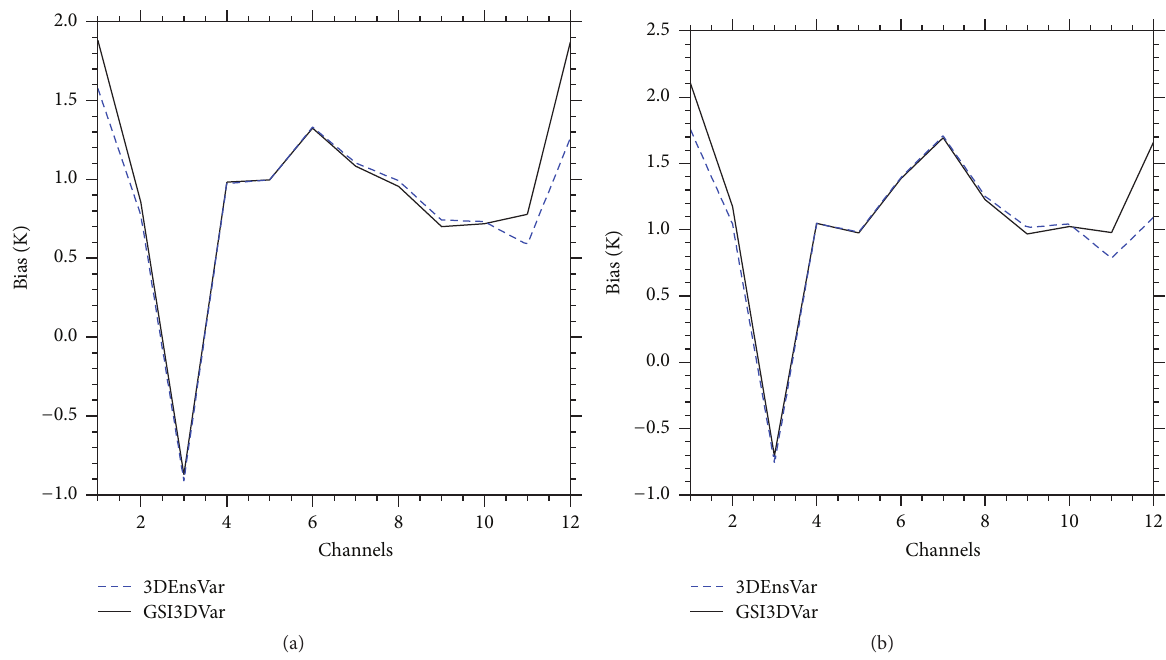
Figure 11: Bias estimated by the GSI3DVar and the 3DEnsVar averaged over the experiment period for (a) AMSU–METEOP and (b) AMSU– NOAA18 satellites. Bias values are depicted for selected channels. Solid black and dashed blue line represent bias estimated by the GSI3DVar and the 3DEnsVar,